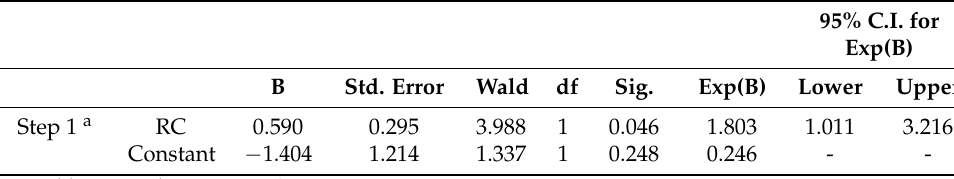
Table 23. Regulatory compliance: regression analysis for IaaS.